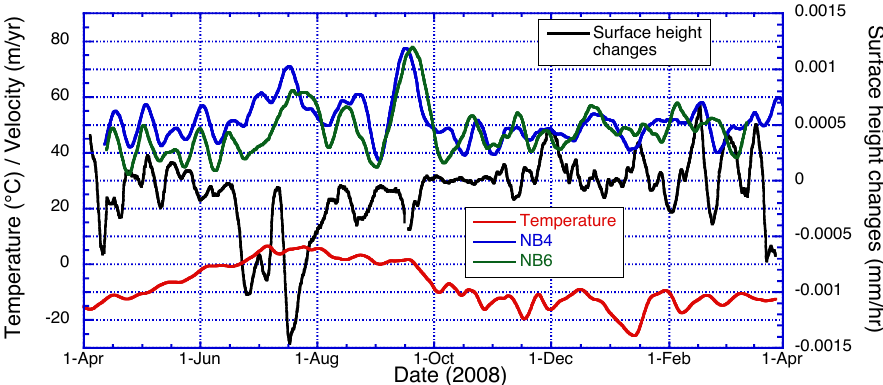
Fig. 8. Time series of temperature, surface height changes and velocity of two stations, NB4 and NB6, for 2008. Surface height changes are derived from sonic height ranger data at NB5H. Negative surface height changes illustrate melt rates. All variables are calculated with a running average of